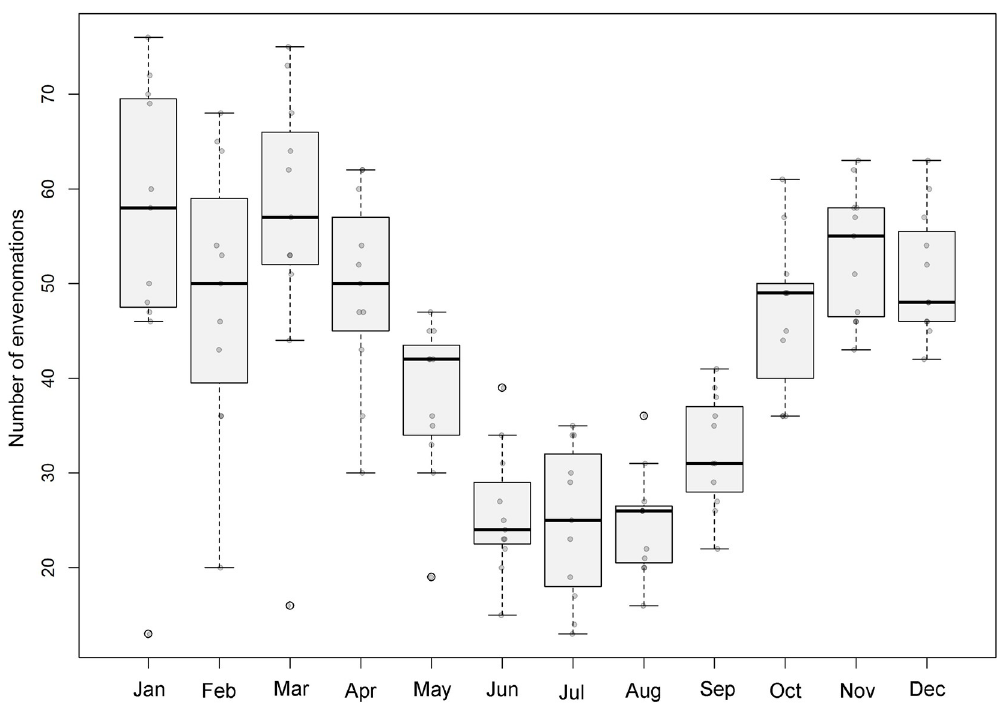
Fig 2. The number of snake envenomations per month between 2007 to 2017 in Mato Grosso do Sul state (Brazil). https://doi.org/10.1371/journal.pntd.0009737.g002 person died by other causes not related to the snake envenomation (0.01%) and, 826 people (14.83%) did not inform about case evolution. Among the registered cases, 51.02% (n = 2841) were categorised as mild, 33.41% (n = 1860) as moderate, and 8.31% (n = 463) as severe (Table 3). Based on spatial distribution, most of the envenomations occurred in Cerrado (62.92%), followed by Atlantic Forest (28.81%), and Pantanal with 8.27% (Fig 4). The municipality of Figueir ã o (n = 103.81), followed by Paranhos (n = 89.29) and Tacuru (n = 82.58) showed the highest incidence of snake envenomations per 100,000 population (Fig 4). However, GLM showed that the number of snake envenomations per municipality in Mato Grosso do Sul state is only related to the municipality area (Z = 4.26, p � 0.01, Fig 5). The variables of biome and population density did not influence the snake envenomations in Mato Grosso do Sul state (p > 0.05). Discussion Snake envenomations epidemiology in Mato Grosso do Sul confirmed trends observed in other Brazilian regions e.g., [4,7,22], happening mainly in October and April. Most of the Table 1. Number of snake envenomations by sex in Mato Grosso Do Sul state, Brazil, between 2007 to 2017. Sex